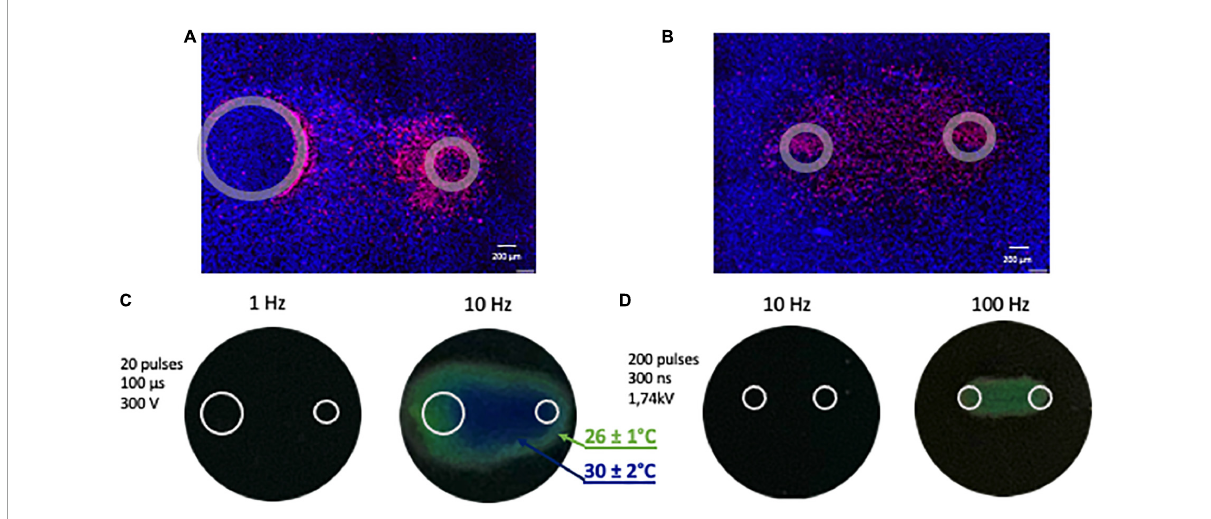
FIGURE2 Representative images illustrating fluorescent staining of human cardiomyocyte monolayers and temperature monitoring. (A) Cells were subjected to 20 pulses (100 µ s duration, 1 Hz, 300 V) and (B) 200 pulses (300 ns duration, 10 Hz, 1.74 kV). Panels (A,B) show merged signals from Hoechst-33342 (blue) and propidium iodide (red). Gray circles mark the footprints of the asymmetrical (A) and symmetrical (B) electrodes. (C,D) Monitoring the temperature rise following PEF (pulsed electric field) exposure with thermochromic liquid crystal sheets. Images were taken at the end of the exposure. Temperatures at the color transitions are labeled in the legend.